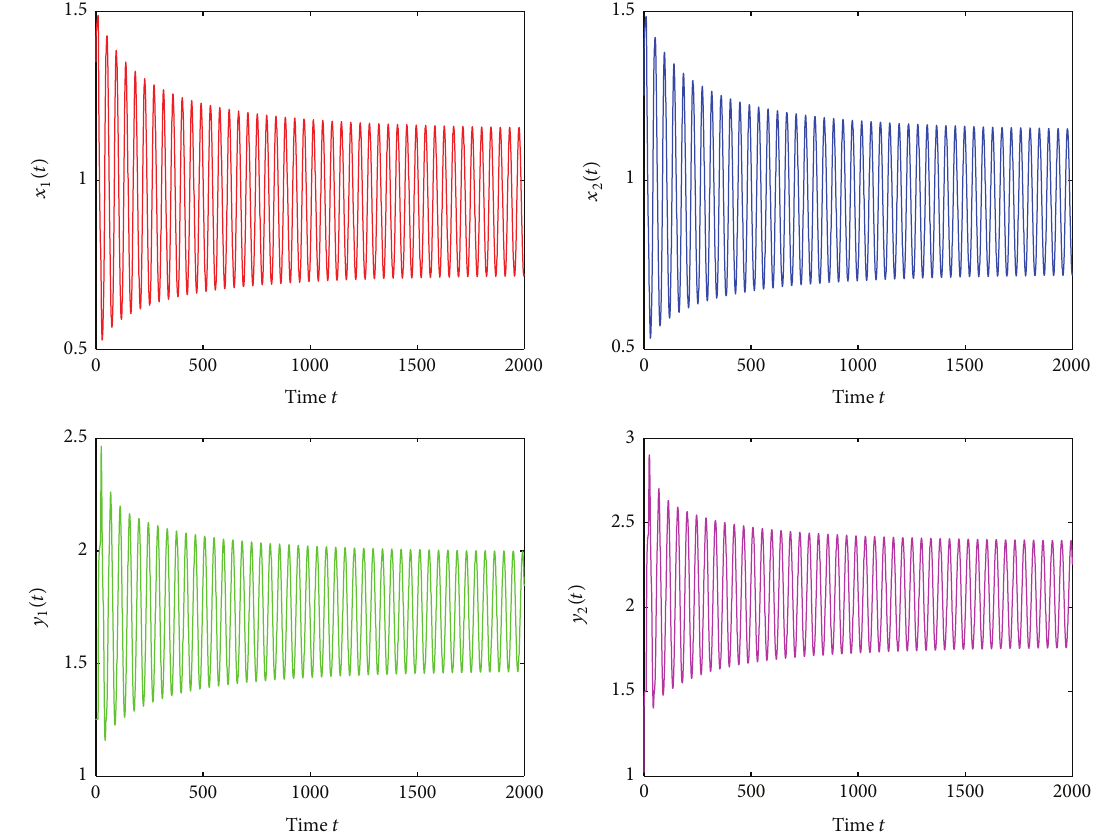
Figure 10: The track of the states 𝑥 1 , 𝑥 2 , 𝑦 1 , 𝑦 2 for 𝜏 2 = 10.7500 > 𝜏 20 = 9.9183 .